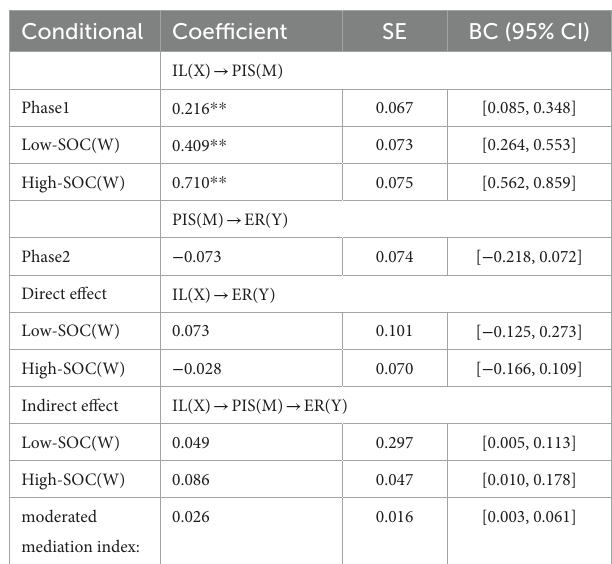
TABLE 6 Bootstrap analysis results of Moderated Mediating Effect.